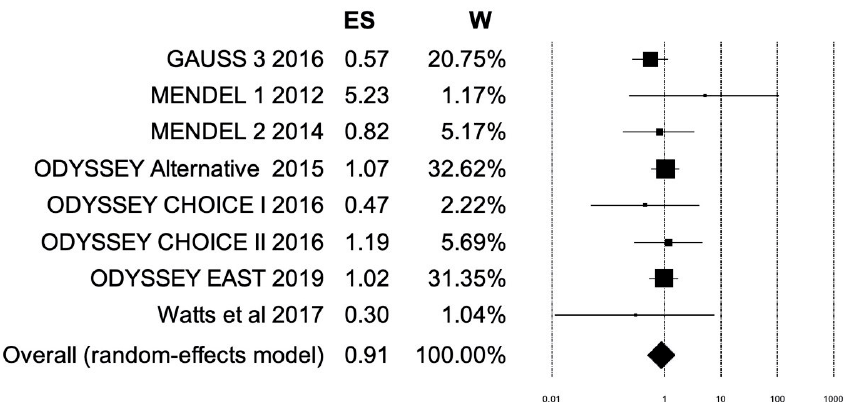
Figure 6. Funnel plot for meta-analysis of incidence of myalgia. Funnel depicts no publication bias for meta-analysis of myalgia incidence in anti-PCSK9 group vs. control group.